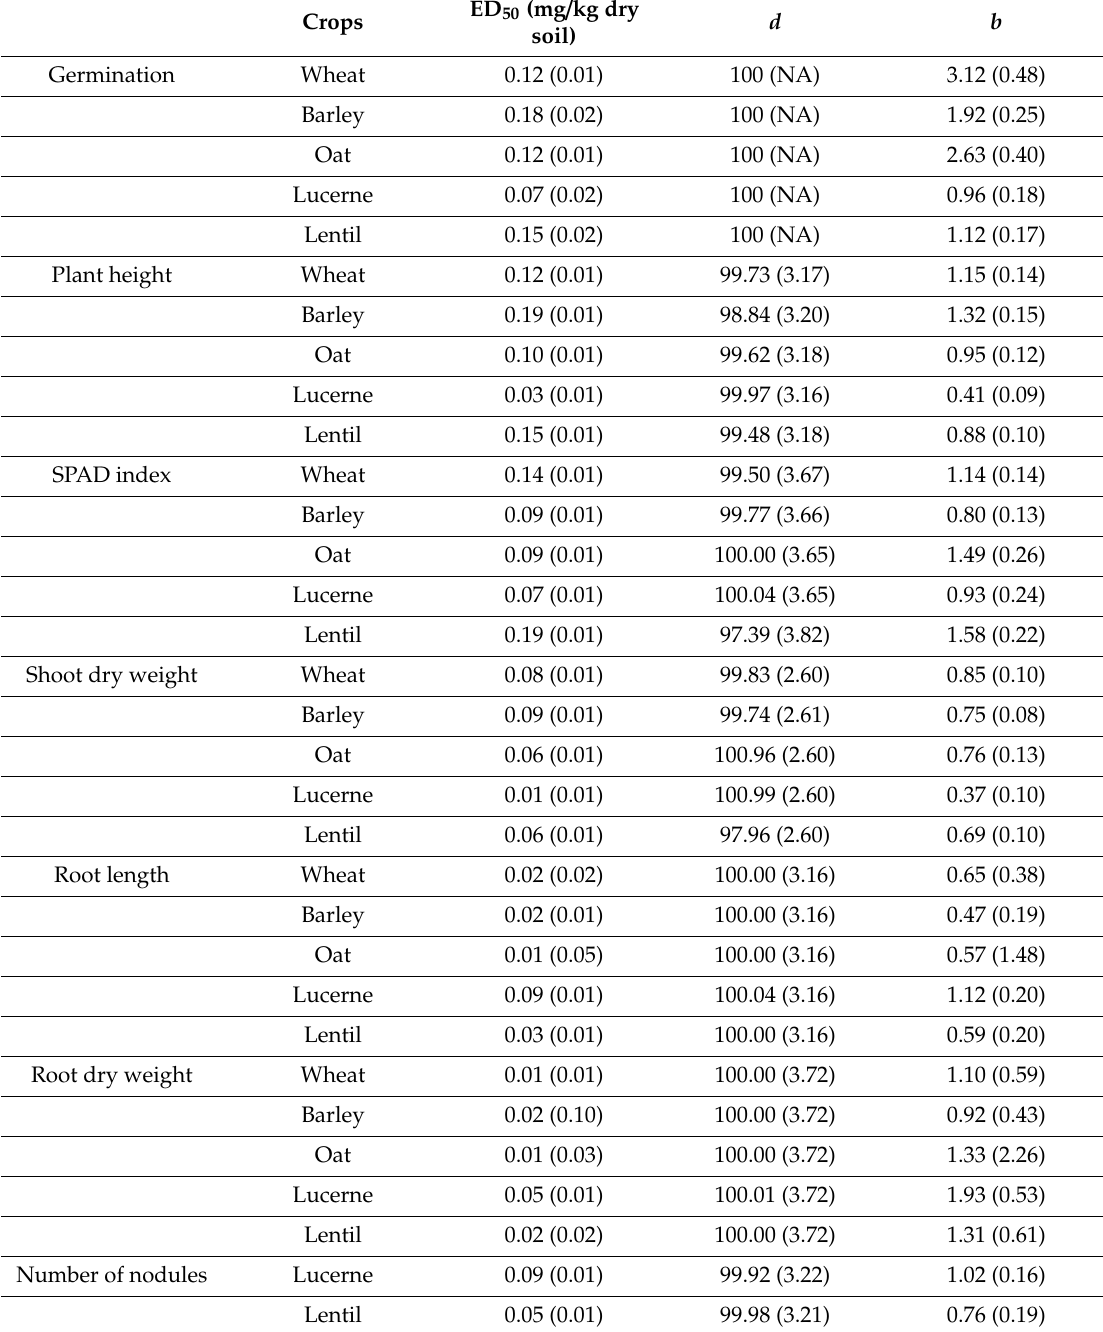
Table 1. Estimated regression parameters of the two parameter log-logistic model, four parameter Weibull model (Weibull1) and four parameter log-logistic model for the shoot and root parameters of wheat, barley, oat, lucerne and lentil against various levels of trifluralin concentrations as per equations 1, 2 and 3 mentioned in materials and methods